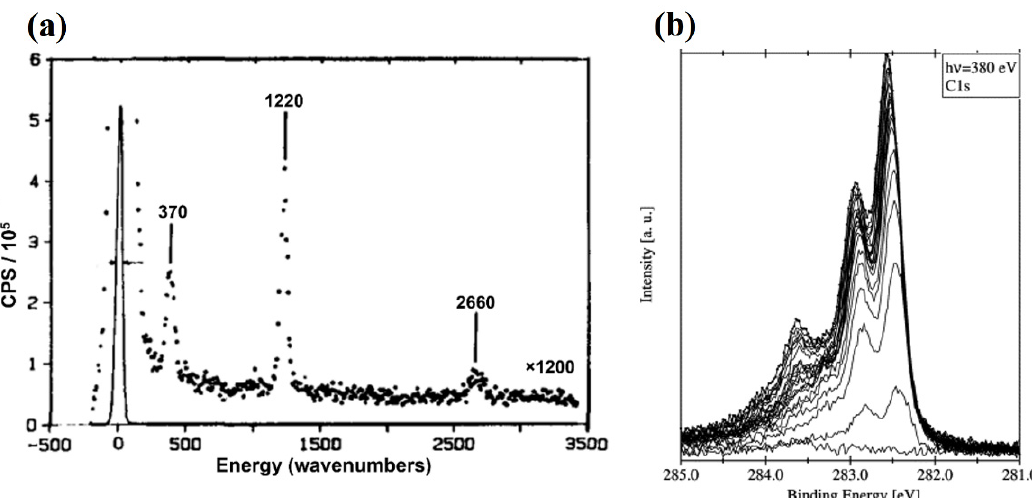
Figure 5. ( a ) HREEL spectrum after CH 4 decomposition on Ni (111) surface [21]. ( b ) Spectra collected on Pt (111) surface to a methane molecular beam (T = 1073 K, seeding ratio: 5% CH 4 in He) [22].